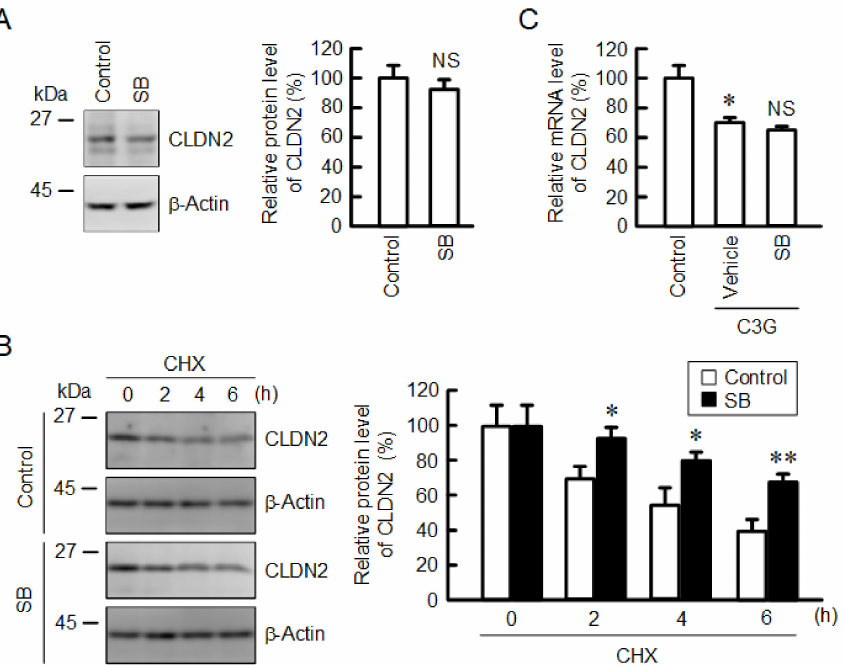
Figure 8. Effects of anisomycin and SB203580 on CLDN2 expression. ( A ) Cells were incubated in the absence (vehicle) and presence of 10 µ M SB203580 (SB) for 24 h. Cell lysates were immunoblotted with anti-CLDN2 and anti- β -actin antibodies. The protein levels of CLDN2 are represented as a percentage relative to vehicle. ( B ) Cells were incubated with 10 µ M CHX in the absence (control) and presence of 10 µ M SB203580 (SB) for 0, 2, 4, and 6 h. The protein levels are represented relative to 0 h. ( C ) Cells were incubated in the absence (control) and presence of 10 µ M C3G and 10 µ M SB203580 for 6 h. The mRNA levels are represented as a percentage relative to control. n = 3–4. ** p < 0.01 and * p < 0.05 compared with 0 µ M or control. NS p > 0.05 compared with